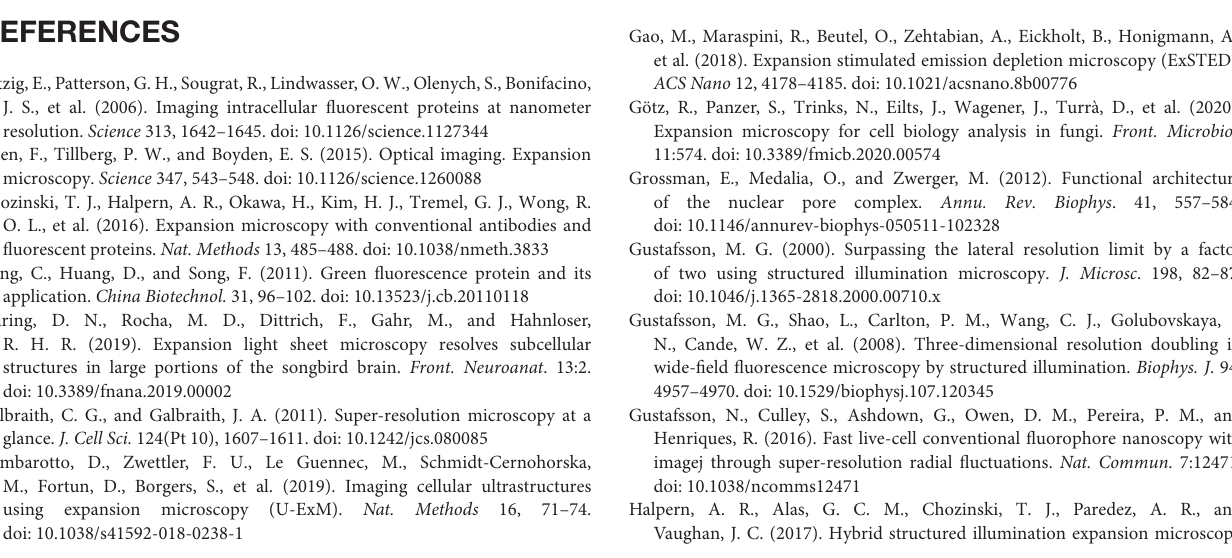
Supplementary Figure 1 | Diameters of Nup153 ring measured in FEAST